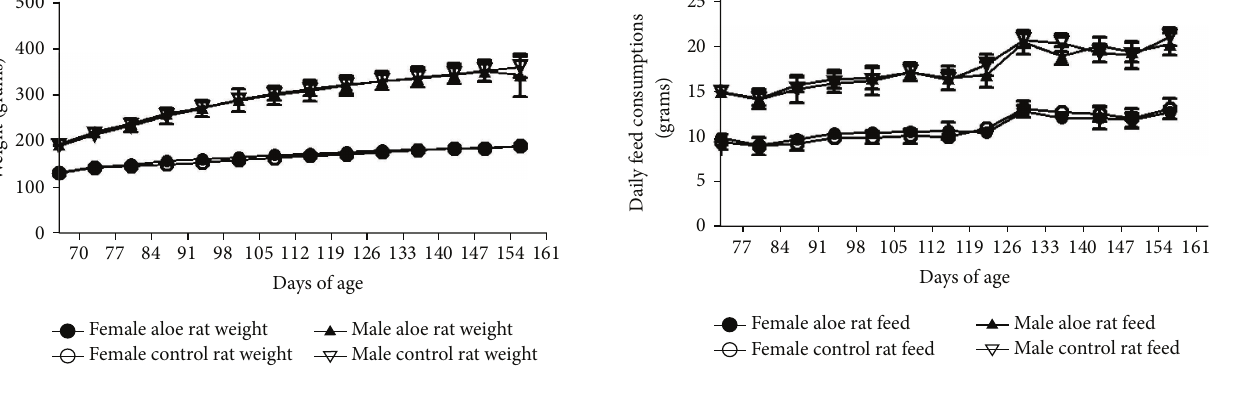
Figure 2: Weekly body weights of male and female rats fed DCWL aloe vera diet over 13 weeks. The symbols represent mean values for control and aloe-fed groups error bars show standard deviations.